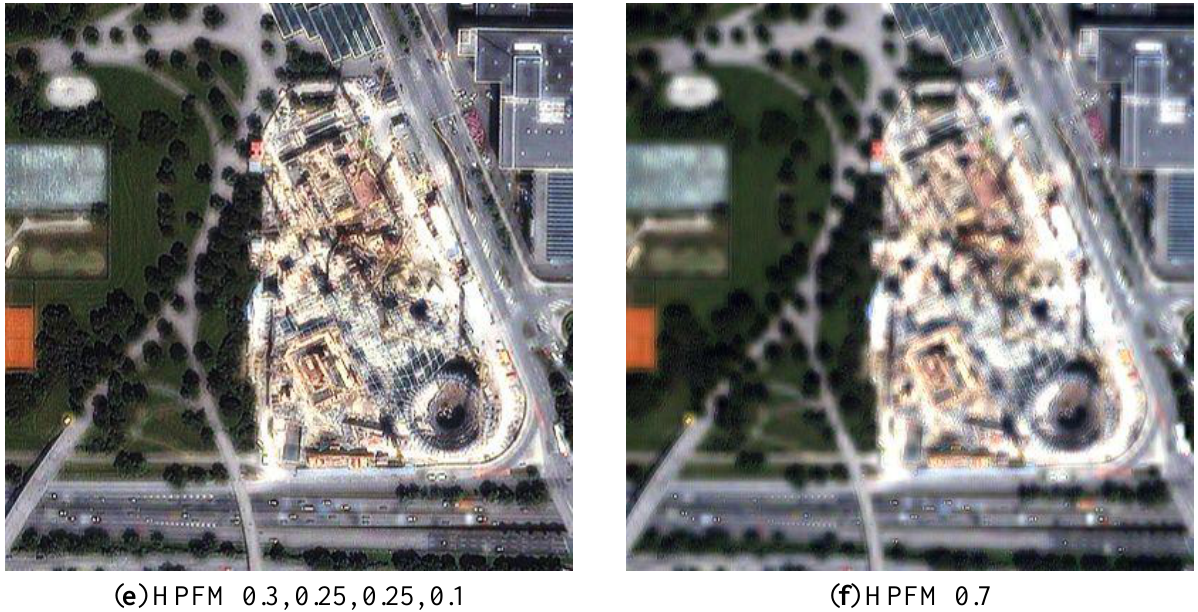
Figure 11. Bilinear interpolated bands: 3, 2, 1 ( a ), panchromatic band ( b ) and HPFM fusion with variable image quality controlled by parameters: 0.05 ( c ), 0.15 ( d ), band dependent parameters: 0.3, 0.25, 0.25, 0.1 ( e ) and 0.7 ( f ) for IKONOS